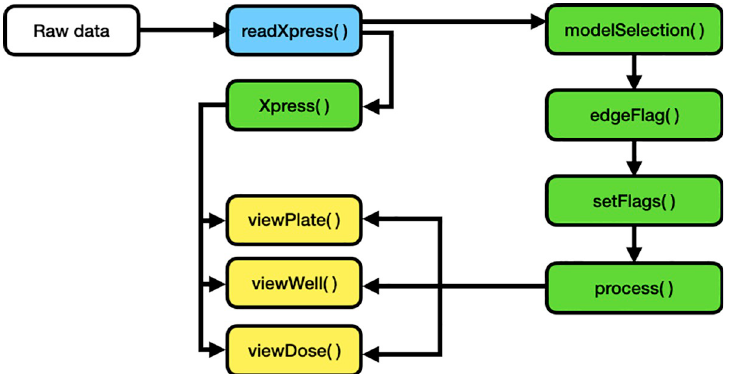
Fig 1. easyXpress workflow. The suggested workflow for using the easyXpress package starts with raw data generated from CellProfiler. For more information on implementing CellProfiler to generate data, see https://github.com/ CellProfiler and https://github.com/AndersenLab/CellProfiler. Reading steps are shown in blue, processing steps are shown in green, and visualization steps are shown in yellow.